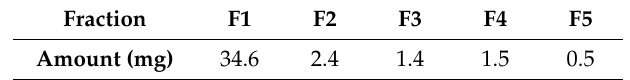
Table 1. Amount (mg) of fractions recovered after size exclusion chromatography.